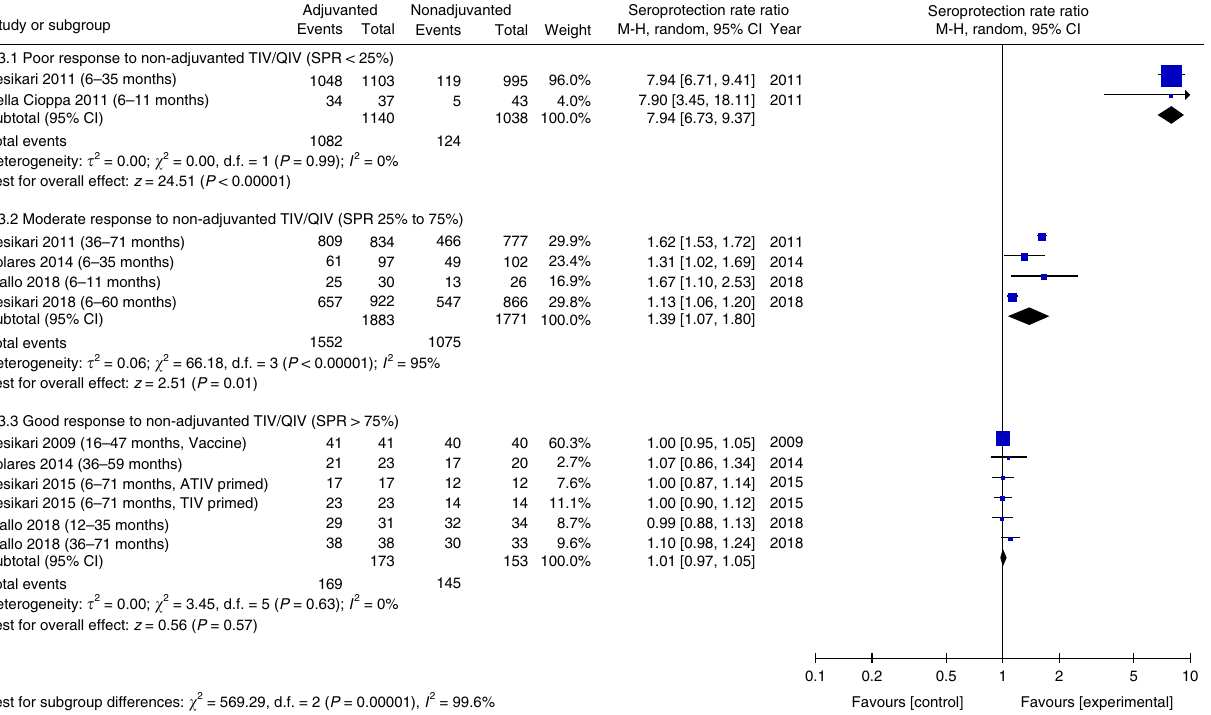
Fig. 5 Forest plot showing the ratios of the seroprotection rate (SPR) against H3N2, de fi ned as a ≥ 1:40 hemagglutinin inhibition (HI) titer, 21 – 28 days after the fi rst dose among children who received adjuvanted versus non-adjuvanted trivalent vaccines (TIVs) or quadrivalent vaccines